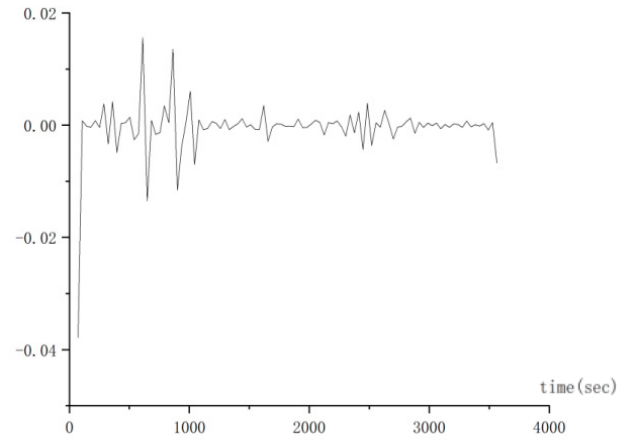
Figure 7. First-order difference sequence with time delay.